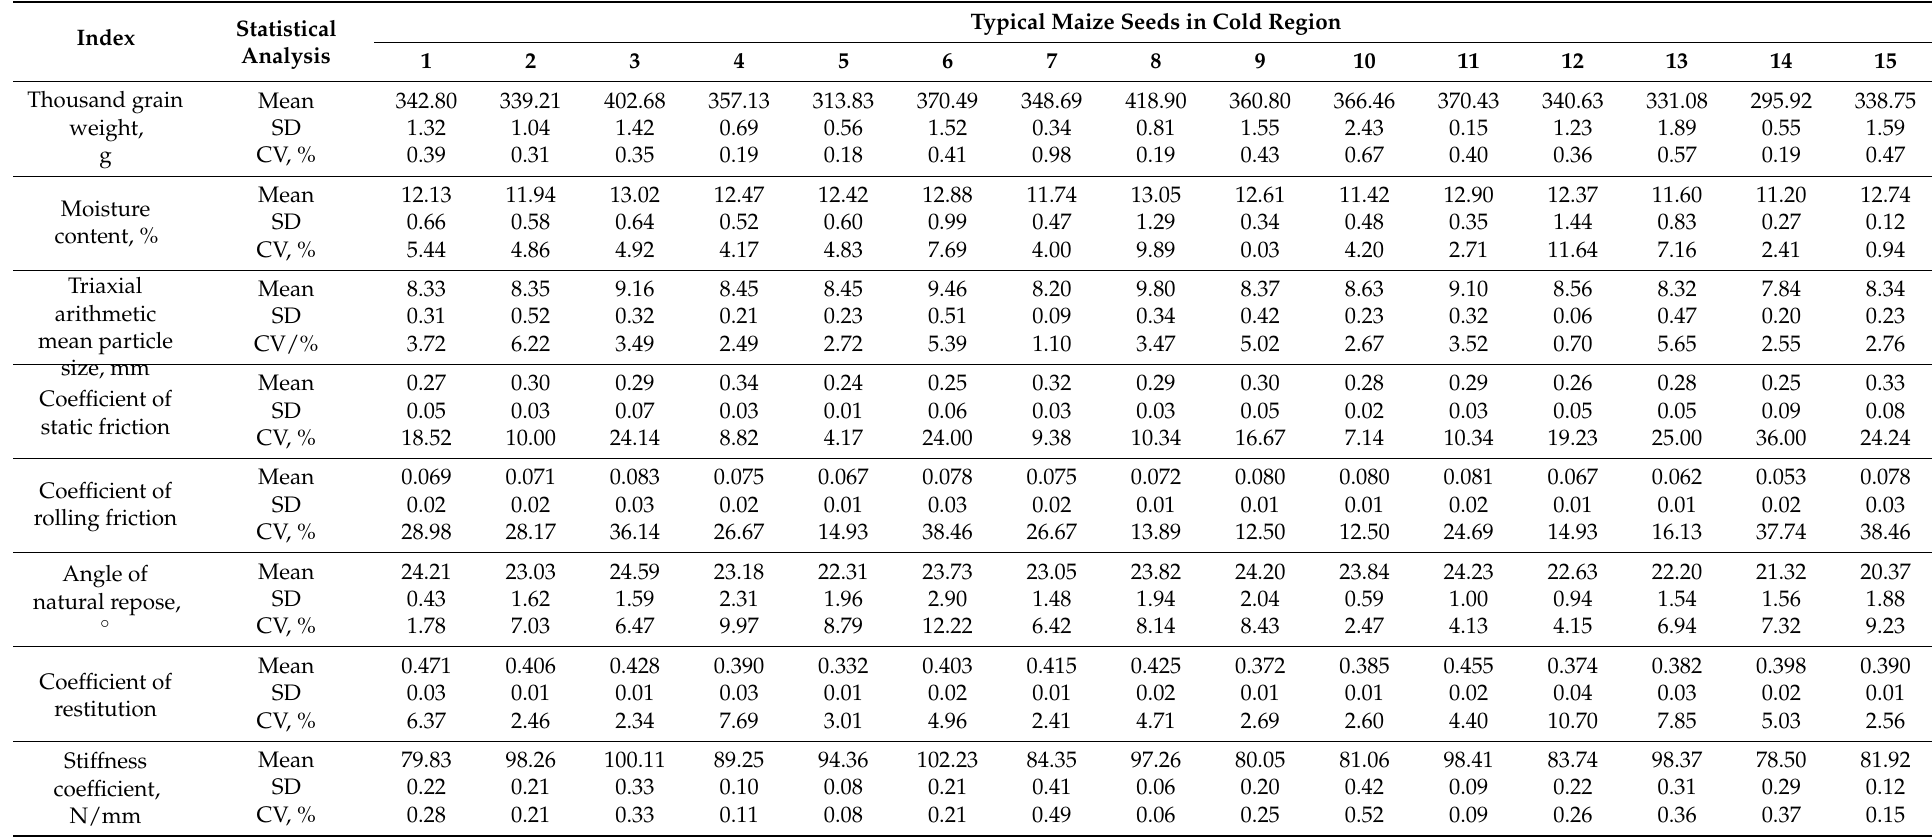
Table 3. Parameters of physical characteristics of typical maize seeds in cold